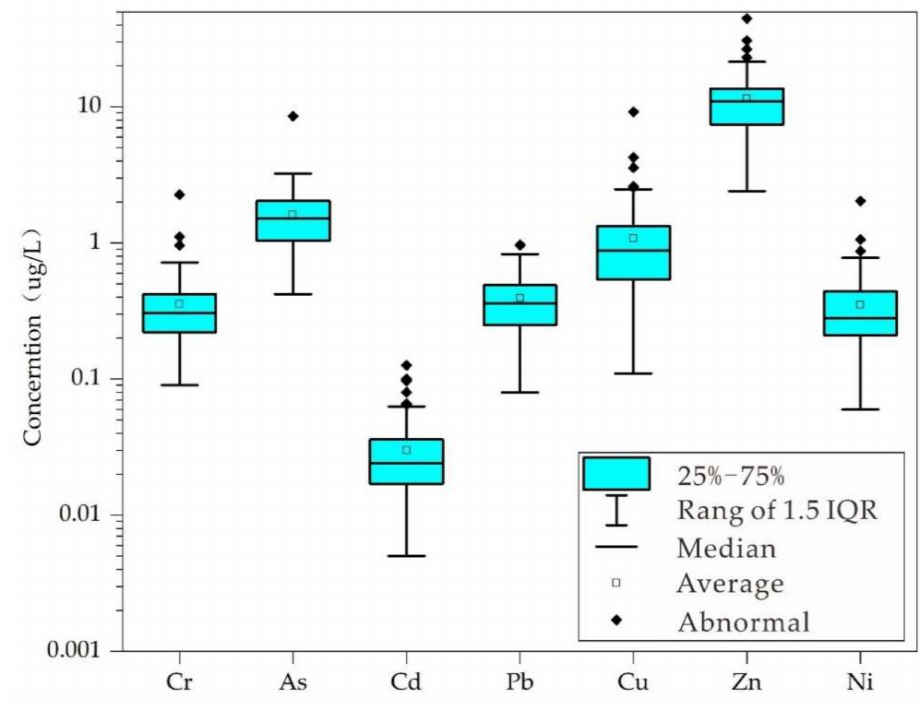
Figure 2. Boxplot of heavy metal